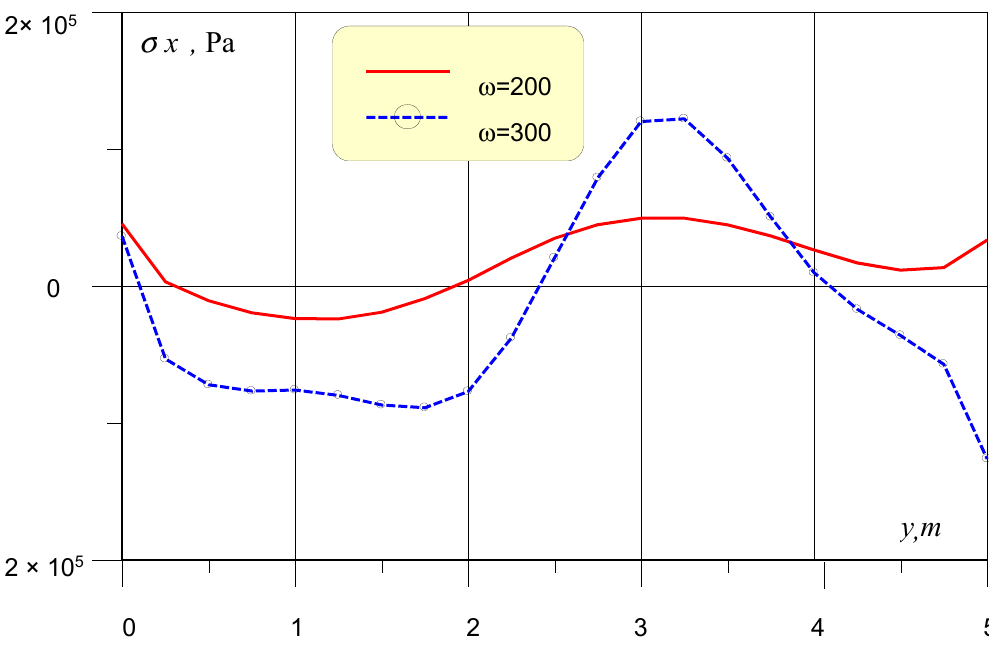
Figure 2. Normal stresses on lower edge of foundation.